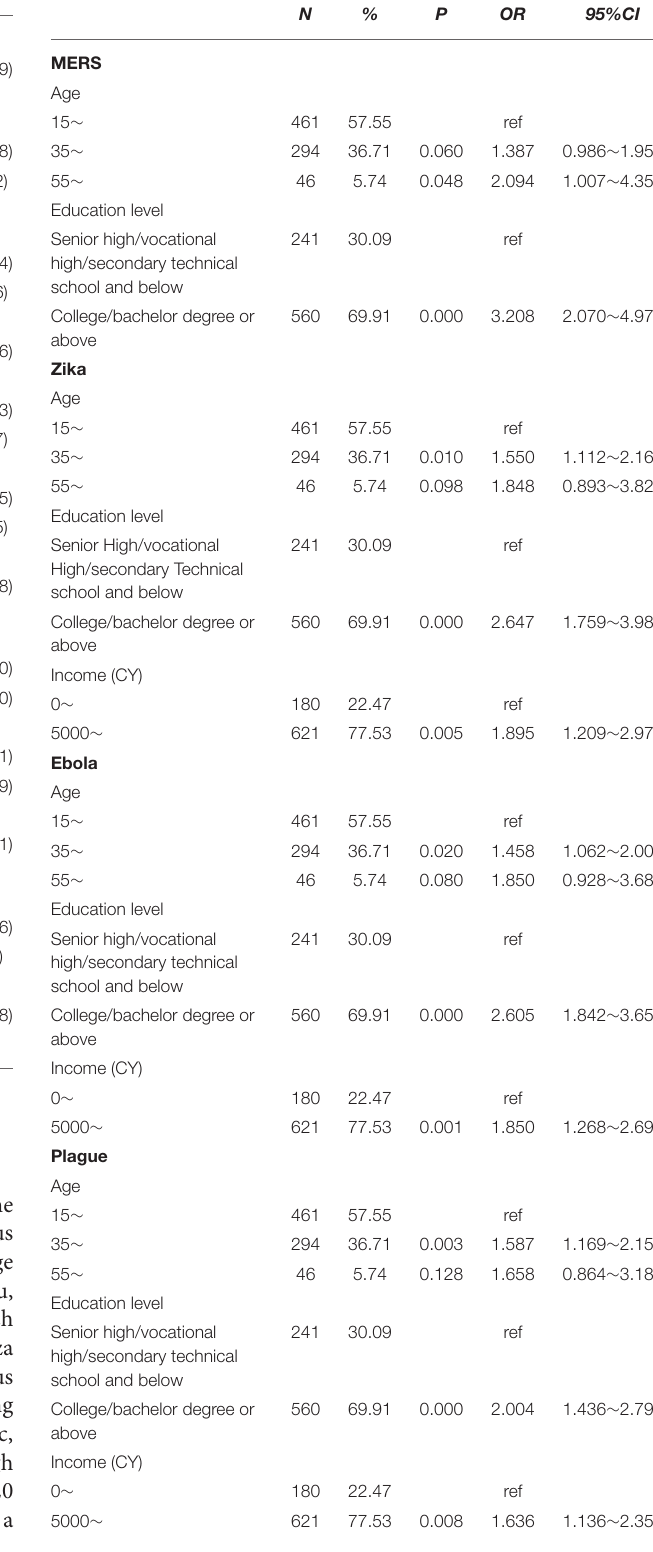
TABLE 2 | Related perception of emerging and reemerging infectious diseases. Knowledge